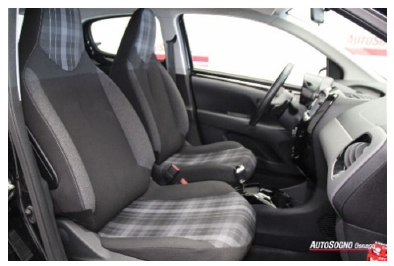
Figure 6. Peugeot